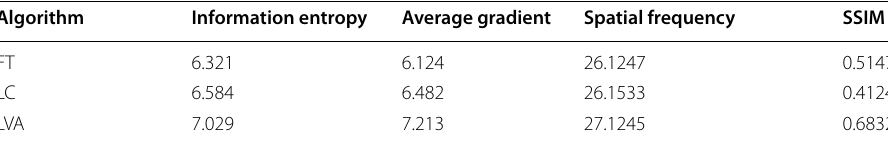
Table 3 Evaluation indicators related to the three algorithms Algorithm